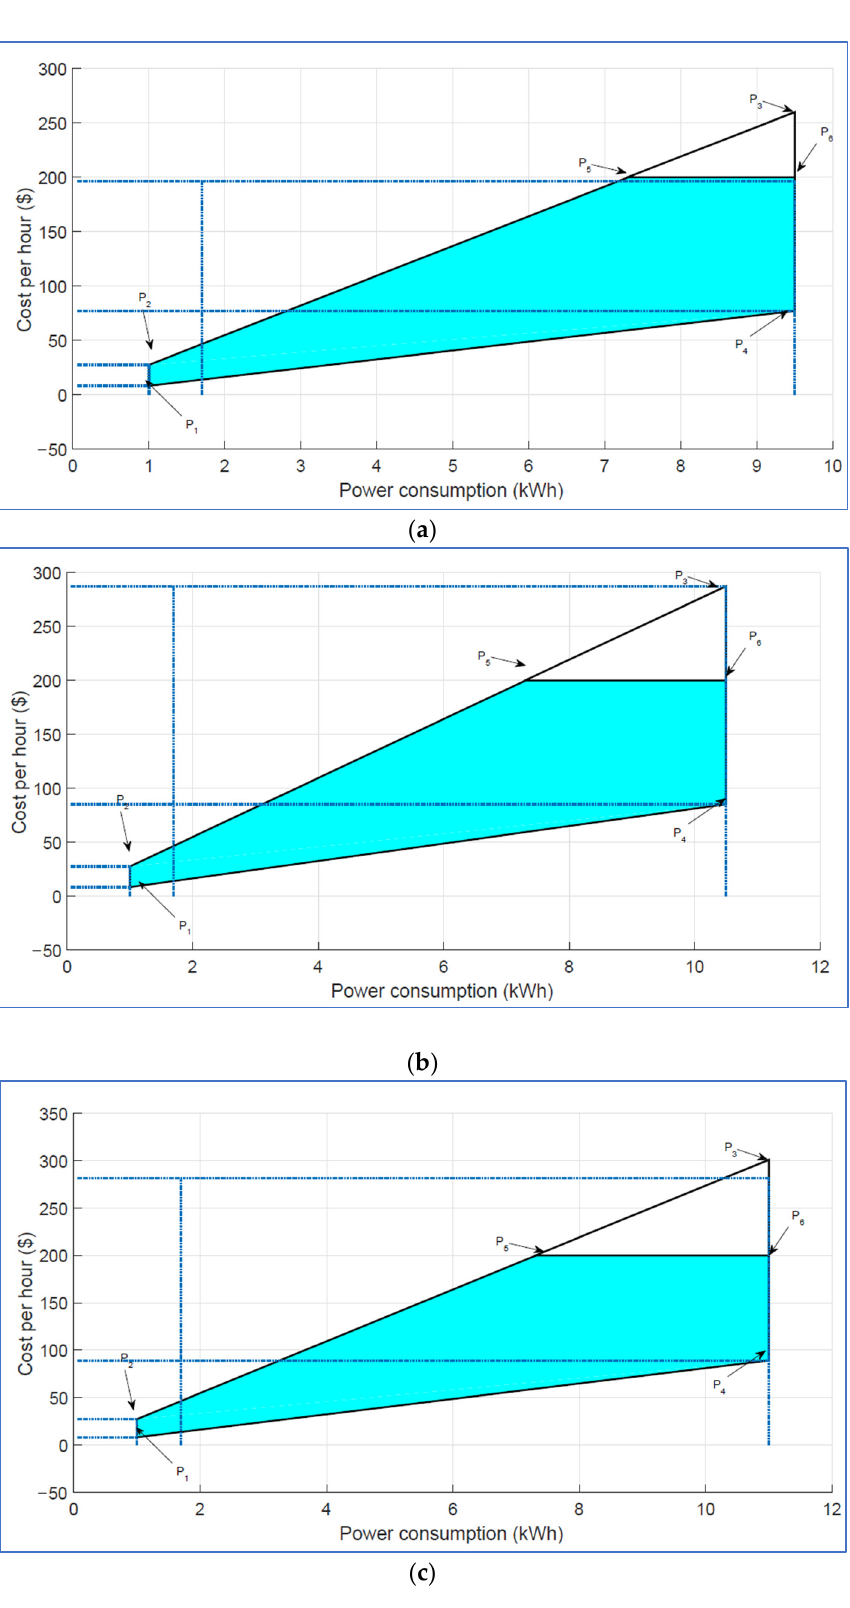
Figure 8. ( a ) Feasible region for 10 homes. ( b ) Feasible region for 30 homes. ( c ) Feasible region for 50 homes.